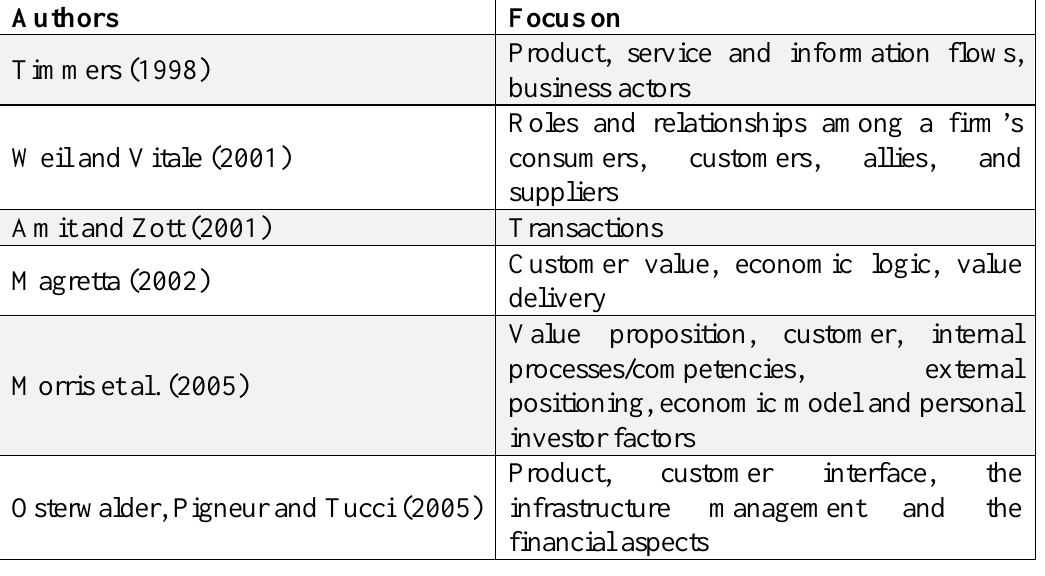
Table 1: Literature